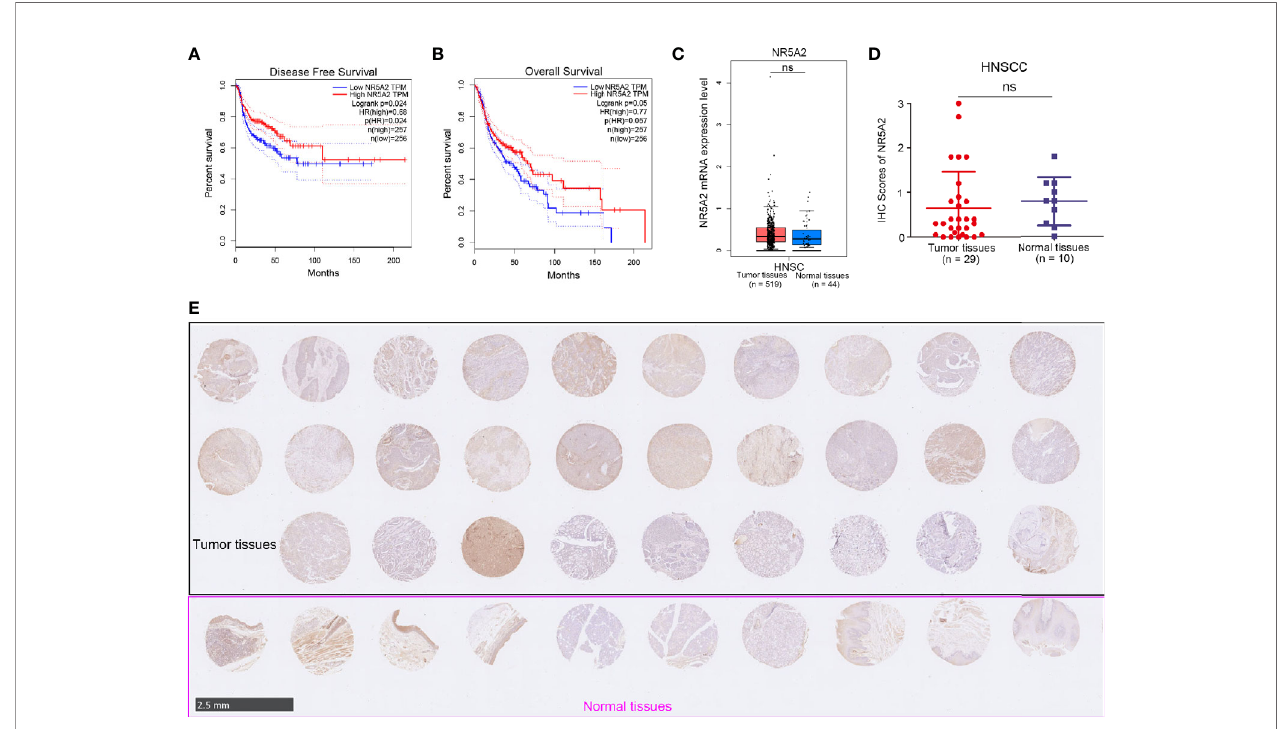
FIGURE 4 | The clinical-pathological feature of NR5A2 in HNSCC. (A, B) The disease-free survival (A) and overall survival (B) of NR5A2 in HNSCC analyzed by the GEPIA web tool, P values as indicated. (C) The mRNA expression level of NR5A2 analyzed by the GEPIA web tool, n.s., not signi fi cant. (D, E) The protein levels of NR5A2 from the tissue microarray (n = 10 normal tissues, n = 29 HNSCC tumor tissues) were determined by IHC analysis, n.s., not signi fi